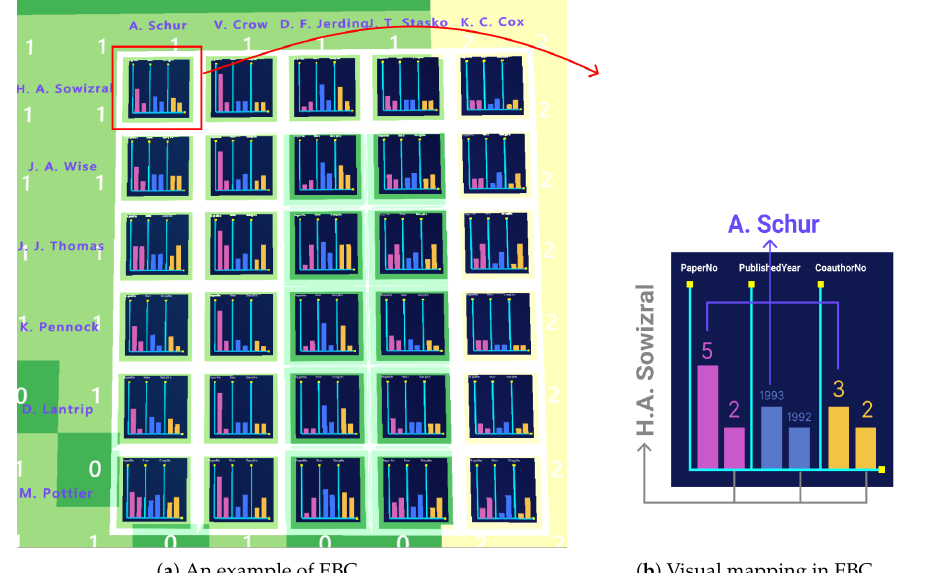
Figure 4. Details of the EBC